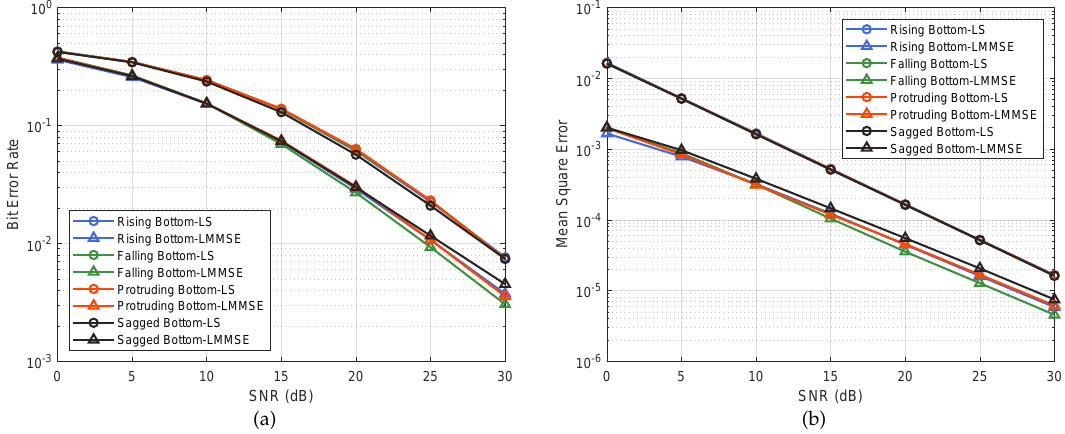
Figure 11. ( a ) BER performance of channels in different sea bottom boundaries, estimated by LS and LMMSE algorithms, respectively. ( b ) MSE performance of channels in different sea bottom boundaries, estimated by LS and LMMSE algorithms,